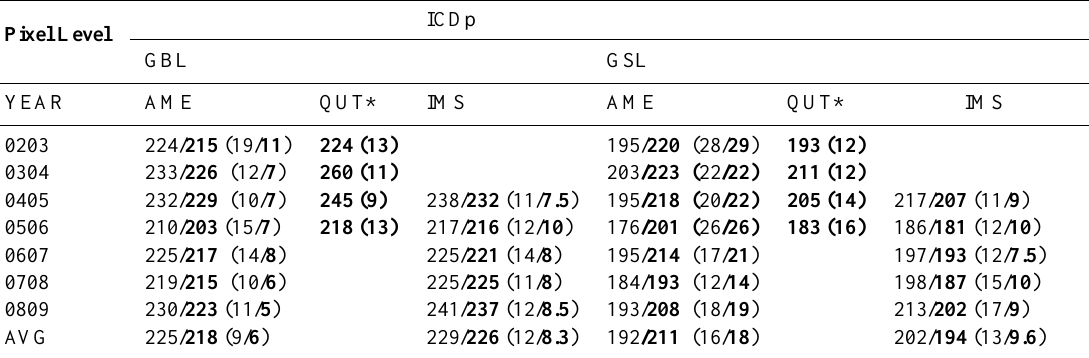
Table 8. Comparison of daily-derived ICDp from AMSR-E (AME), QuikSCAT (QUT) and NOAA/IMS (IMS) products for GBL and GSL (2002–2009). Values within confidence regions in bold. Standard deviation in parentheses. Note that QUT* indicates that ICDp was calculated from FO to ice-off since ice-on was not determined in Howell et al. (2009). Pixel Level